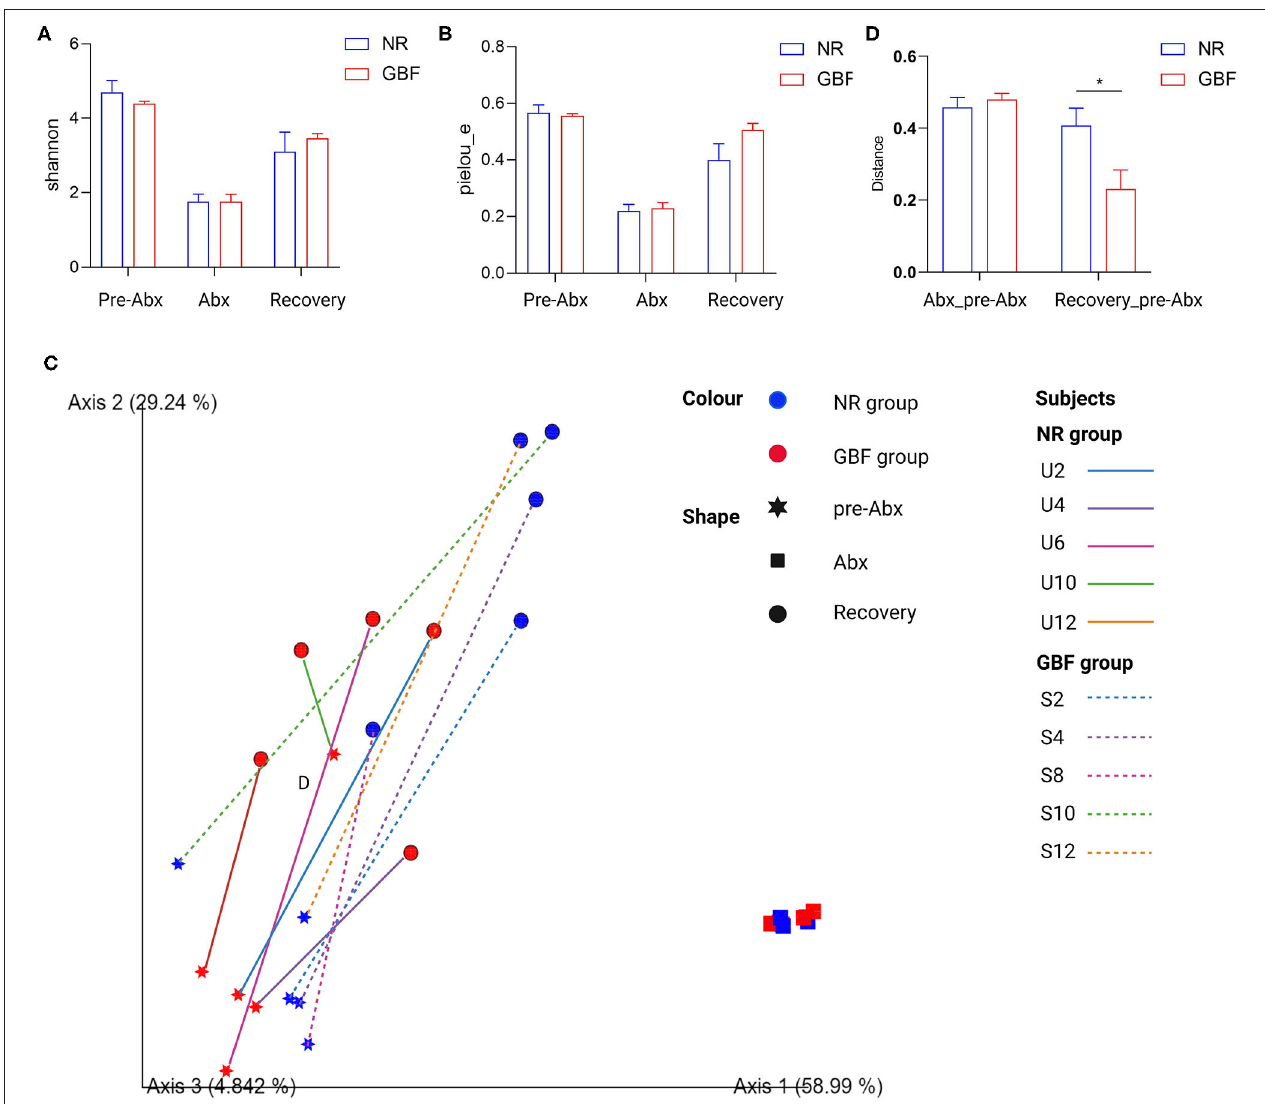
FIGURE 4 | Alpha and beta diversity analysis of gut microbiota in the NR and GBF groups. (A) Alpha diversity analysis of Shannon index from both the groups. (B) Alpha diversity analysis of Pielou’s evenness index from both the groups. (C) Weighted UniFrac principal coordinates analysis (PCoA) plot of the microbiota composition from both the groups. (D) Group significance plots (weighted UniFrac distance between the NR and GBF groups). Significance was determined using the two-tailed unpaired t -tests. The values are expressed as the means ± SEM, n = 5 per group. * P <